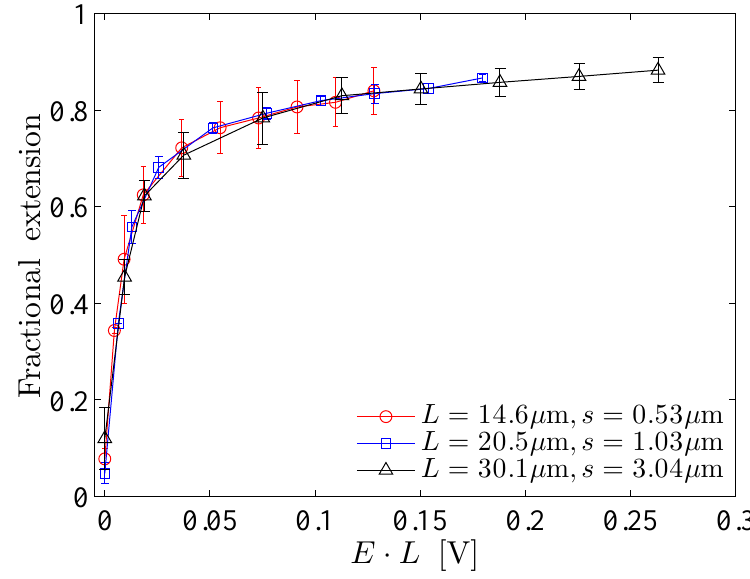
Figure 10. Fractional extension plotted as a function of the product of the applied electric field and the respective molecular contour length. The lines are guides to the eye.